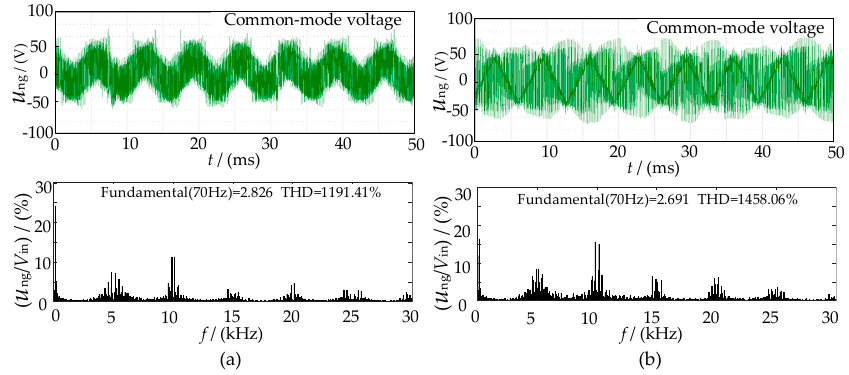
Figure 18. Experimental waveforms and FFT of CMV at m = 0.3 ( a ) method 1; ( b ) method 4.